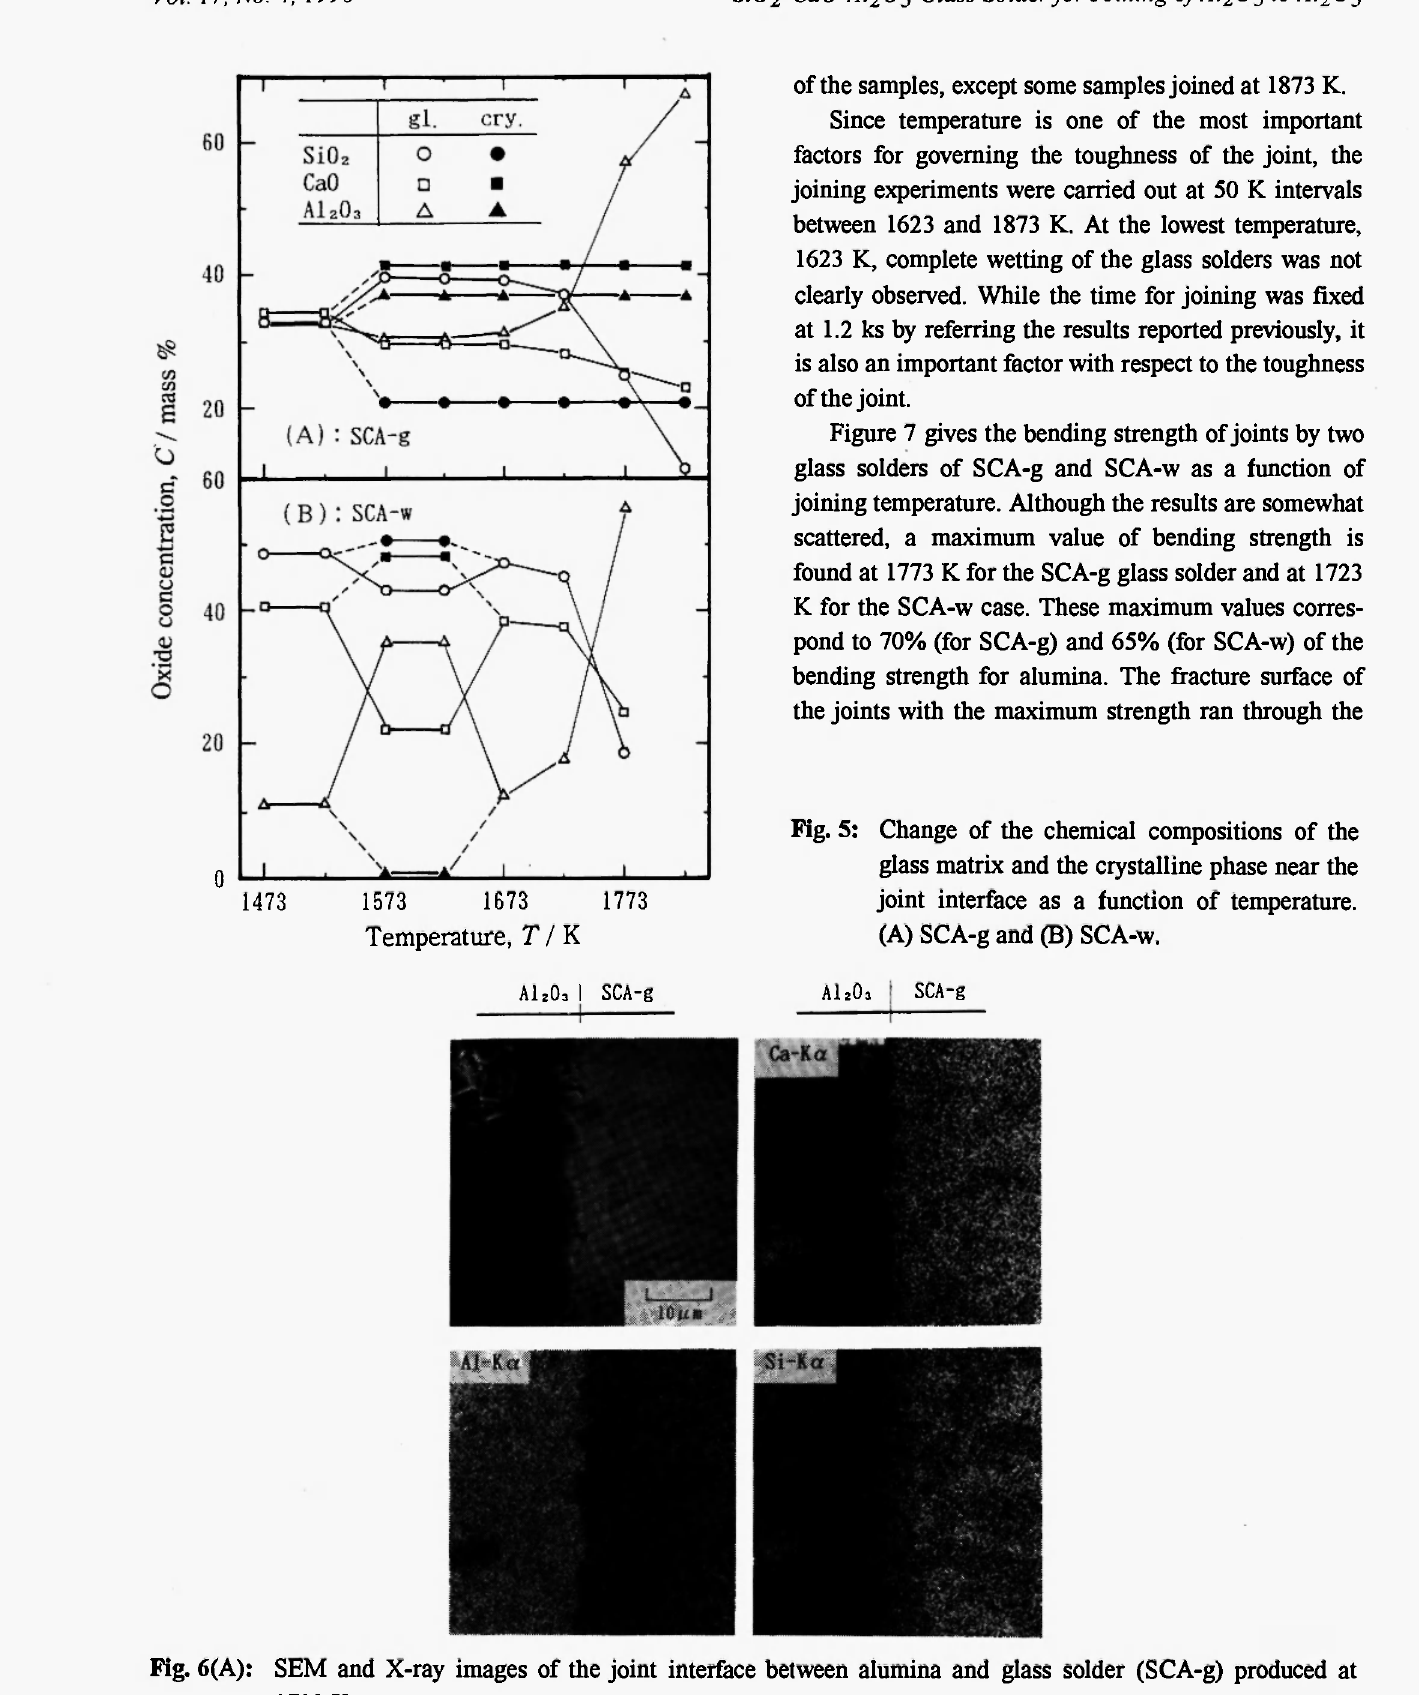
Fig. 6(A): SEM and X-ray images of the joint interface between alumina and glass solder (SCA-g) produced at 1723